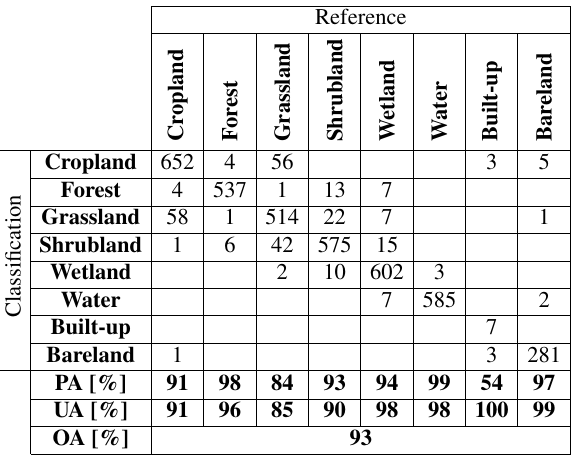
Table 5: Error matrix and accuracy indexes for land cover for 2019